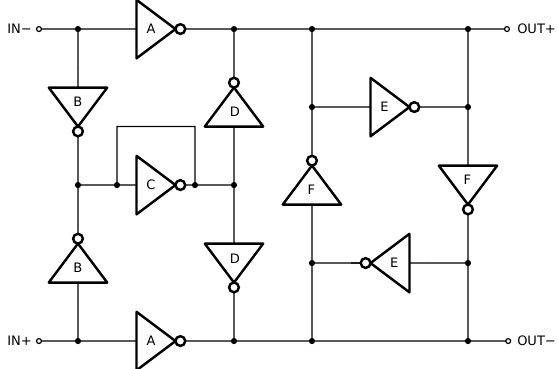
Figure 9. Barthelemy/Nauta (B/N) hybrid OTA circuit